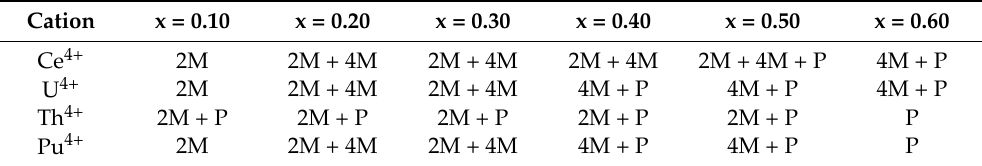
Table 3. Phases in samples of bulk composition CaZr 1 − x (Ce/U/Th/Pu) 4+x Ti 2 O 7 at “x” from 0.1 to 0.6. Cation x = 0.10 x = 0.20 x = 0.30 x = 0.40 x = 0.50 x = 0.60 Ce 4+ 2M 2M + 4M 2M +